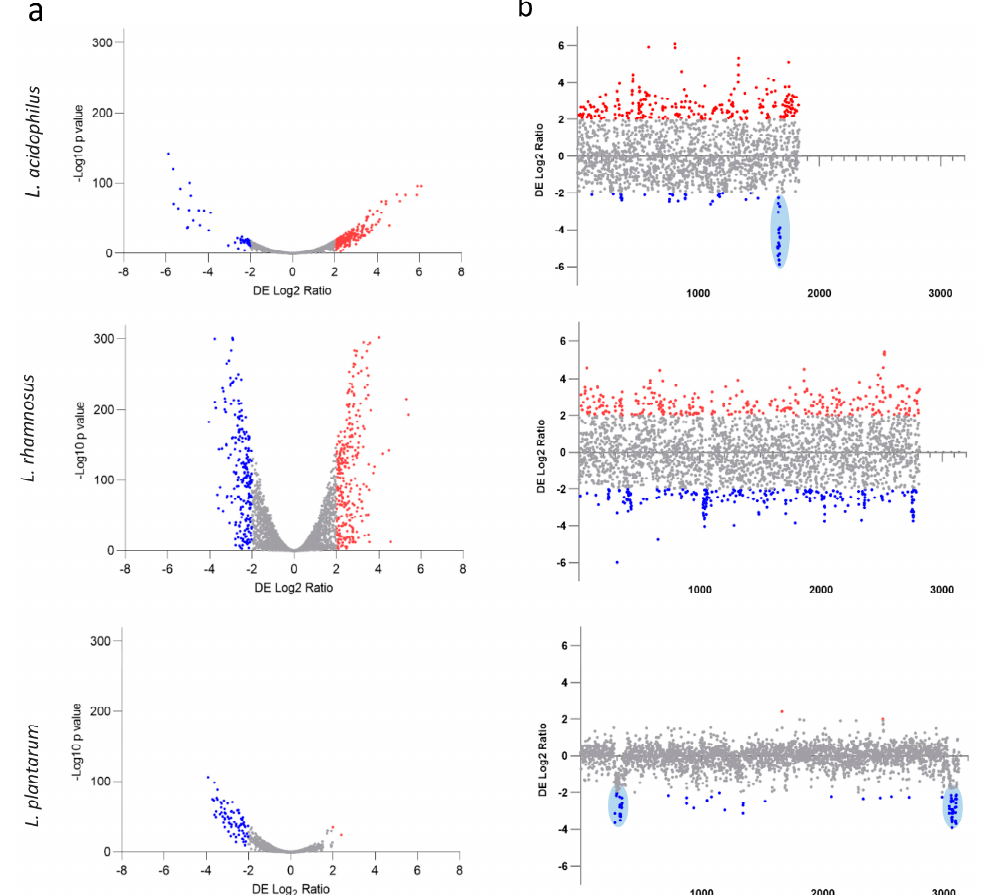
Figure 3. Whole-transcriptome response of probiotic strains to POM extract. Volcano plots comparing Log2 fold change to − Log 10 statistical significance ( a ). Differential gene expression across the chromosome for each of the three strains ( b ). Colors indicate genes with a Log2 fold change ≥ 2 in red and ≤− 2 in blue with a p value ≤ 0.05. Blue ovals indicate regions discussed in the text. Subsequently, we used the differentially expressed gene sets to determine the clusters of orthologous groups (COG) grouping for each strain (Figure 4). The COG